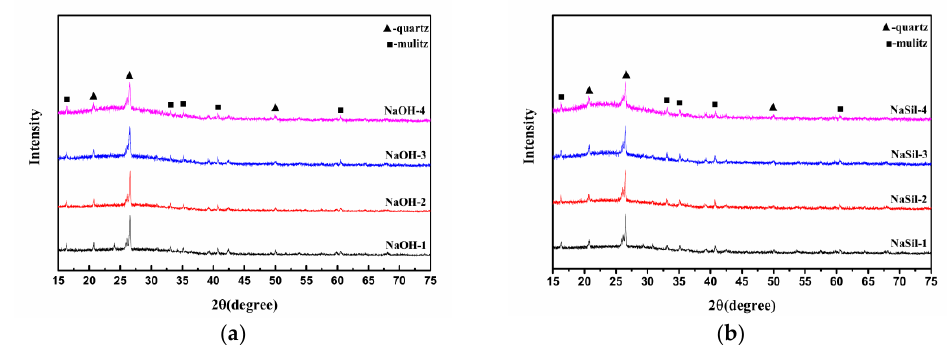
Figure 1. X-ray diffraction (XRD) spectra of the geopolymers fabricated using ( a ) sodium hydroxide activating solution and ( b ) water-glass activating solution.